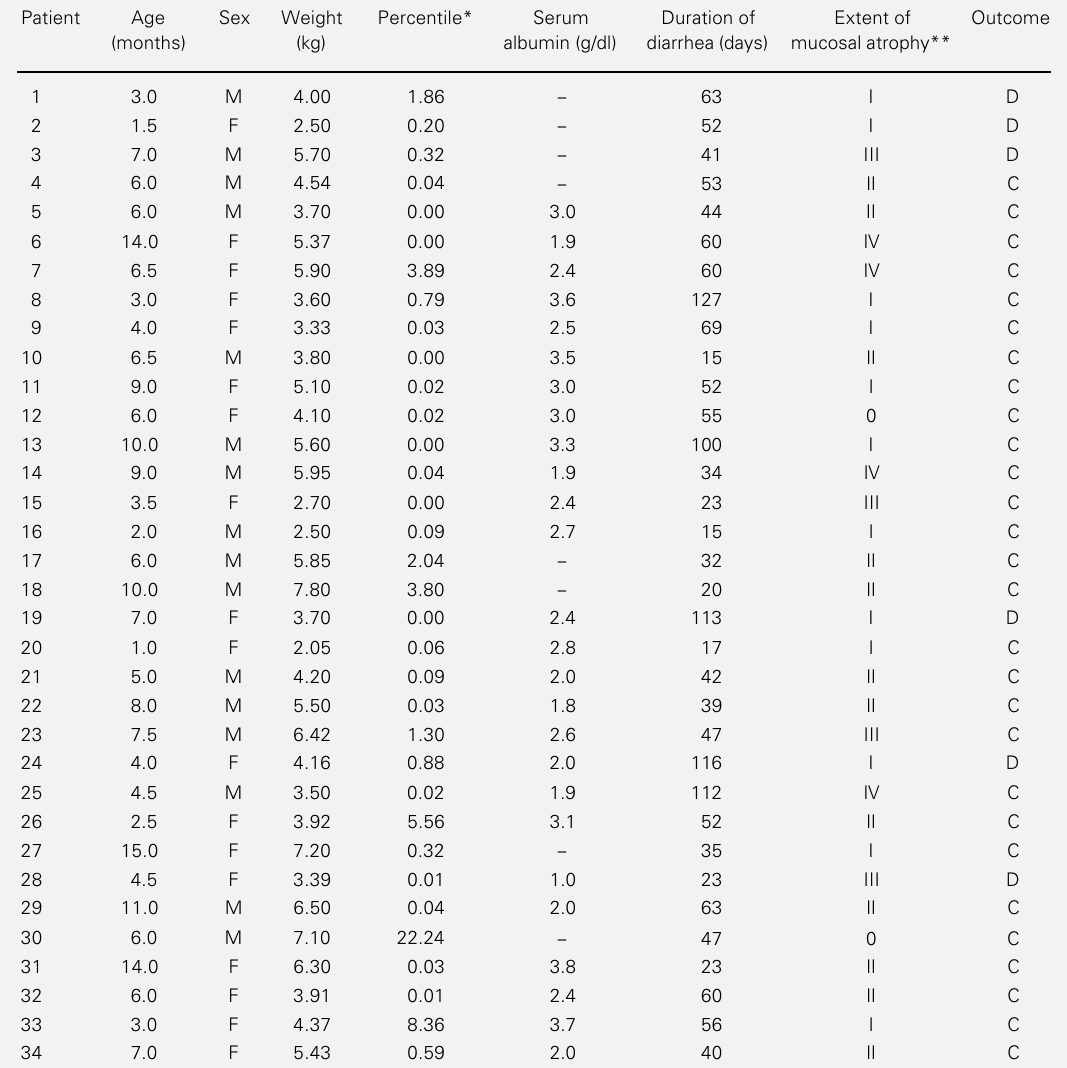
Table 1 - Clinical and laboratory characteristics of patients with protracted